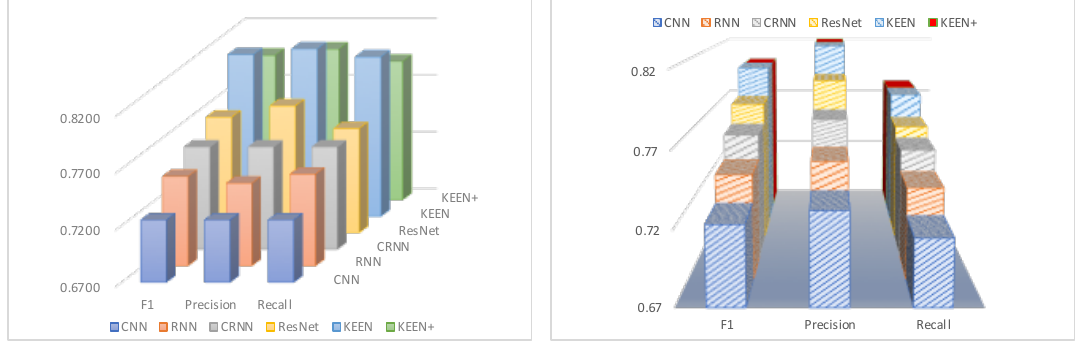
Figure 6. The result of Precision, Recall, F1